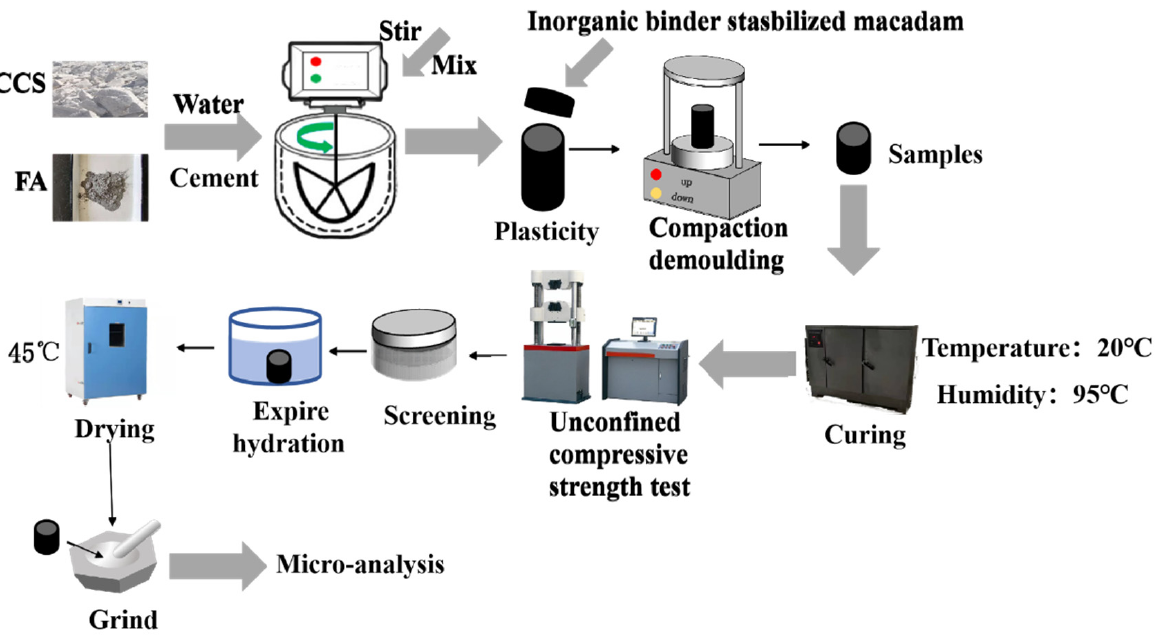
Figure 2. Flow chart for the testing of CSS pavement base materials.